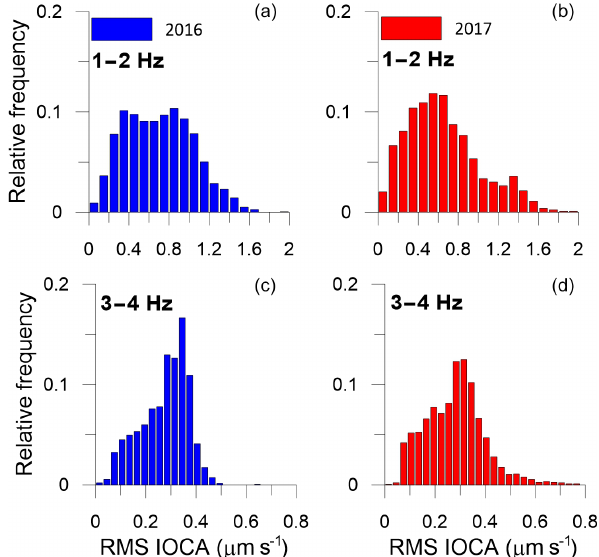
Figure 6. Amplitude distribution of the RMS of the seismic noise recorded during the time interval August–October 2016 (blue) and 2017 (red) in the 1–2Hz (a, b) and 3–4Hz (c, d) frequency